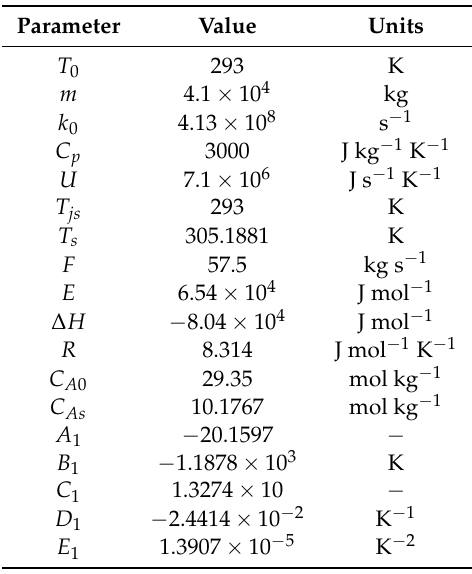
Table 3. CSTR process parameters for the MIC hydrolysis process